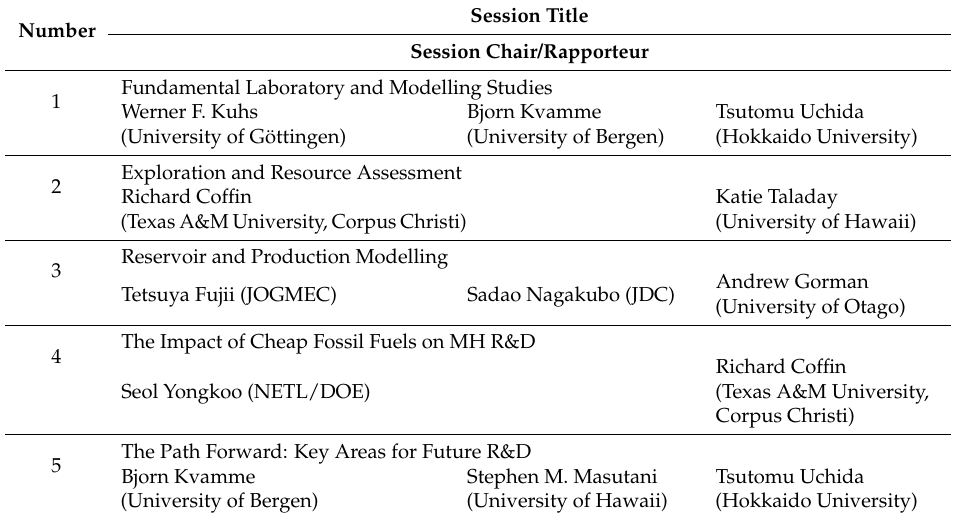
Table 11. Breakout sessions (title and